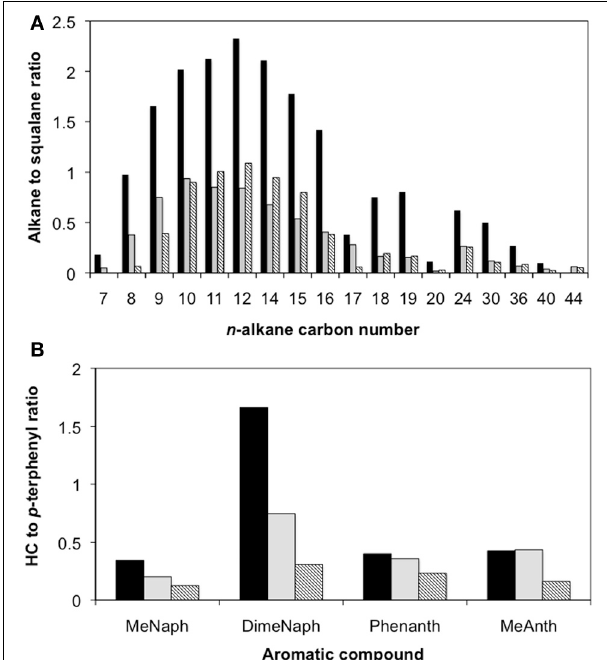
FIGURE 3 | Hydrocarbon loss as a function of the hydrocarbon (HC) to squalane peak area ratios for (A) n -alkanes ranging from C 7 to C 44 , and (B) select polycyclic aromatic hydrocarbons after 315 days of incubation of a crude oil-degrading methanogenic enrichment in sandstone-packed residual oil-containing columns. Striped bars represent the duplicate analyses from an inoculated column, while the black bars represent the uninoculated control. MeNaph, methylnaphthalene; DimeNaph, dimethylnaphthalene; Phenanth, Phenanthrene; and MeAnth, methylanthracene.